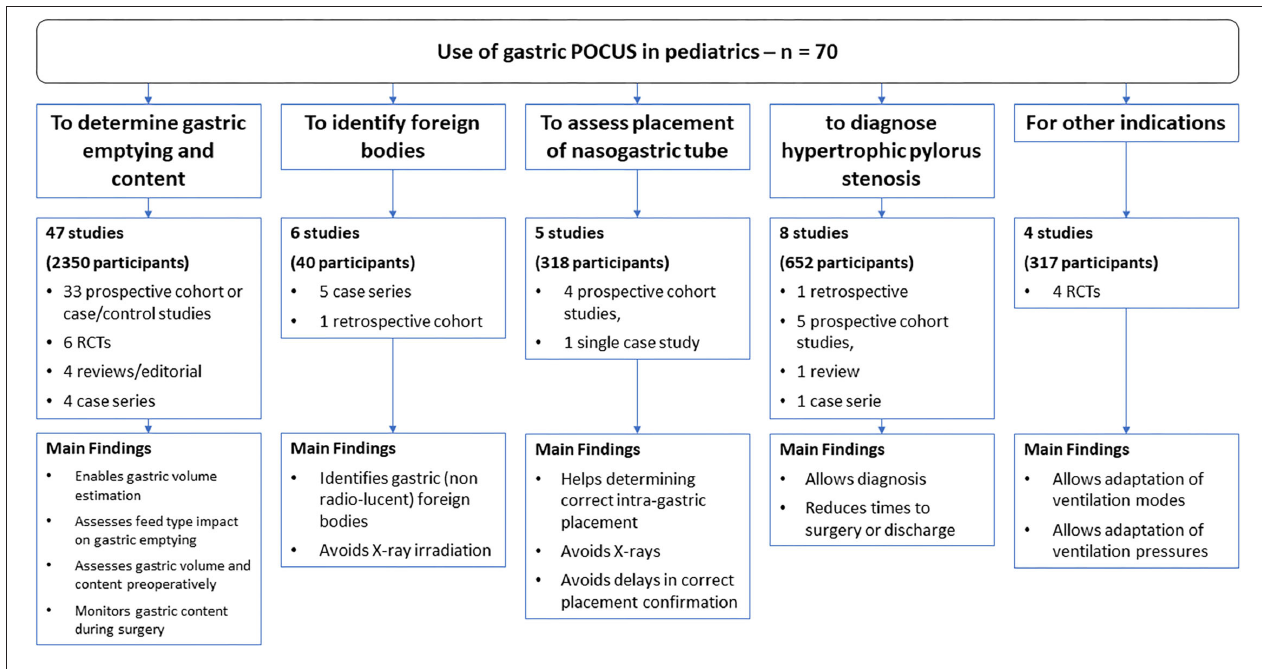
FIGURE 2 | Literature search and main findings.